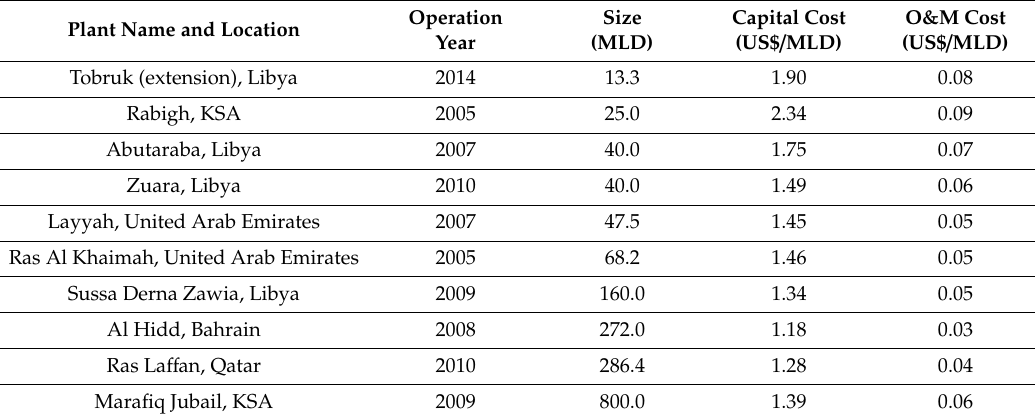
Table 5. Capital and operational costs for different MSF plants in different countries in the MENA region [32] (MLD: million liters per day, O & M: operation and maintenance, KSA: kingdom of Saudia Arabia).